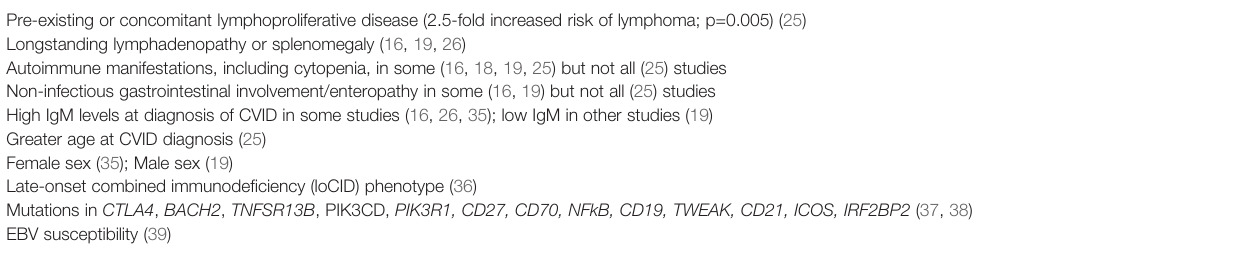
TABLE 1 | Potential predictors of hematological malignancy risk in patients with common variable immune de fi ciency (CVID). Pre-existing or concomitant lymphoproliferative disease (2.5-fold increased risk of lymphoma; p=0.005) (25) Longstanding lymphadenopathy or splenomegaly (16, 19, 26) Autoimmune manifestations, including cytopenia, in some (16, 18, 19, 25) but not all (25) studies Non-infectious gastrointestinal involvement/enteropathy in some (16, 19) but not all (25) studies High IgM levels at diagnosis of CVID in some studies (16, 26, 35); low IgM in other studies (19) Greater age at CVID diagnosis (25) Female sex (35); Male sex (19) Late-onset combined immunode fi ciency (loCID) phenotype (36) Mutations in CTLA4 , BACH2 , TNFSR13B , PIK3CD, PIK3R1, CD27, CD70, NFkB, CD19, TWEAK, CD21, ICOS, IRF2BP2 (37, 38) EBV